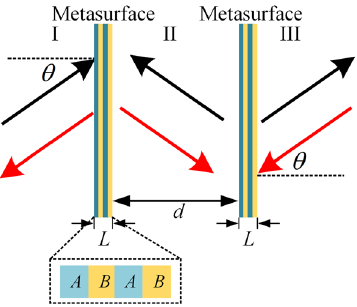
Figure 1. The proposed bidirectional acoustic negative refraction system is composed of a pair of locally PT - symmetric multi-layer metasurfaces separated by a free space with distance d . The black dotted box marks the arrangement of the loss ( A ) and gain ( B ) layers of the locally PT -symmetric